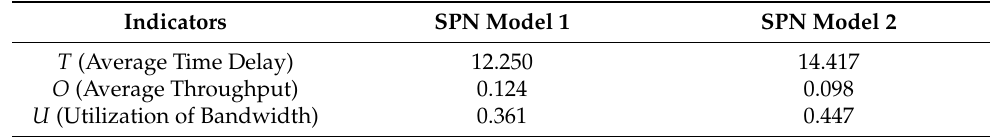
Table 8. Results of performance